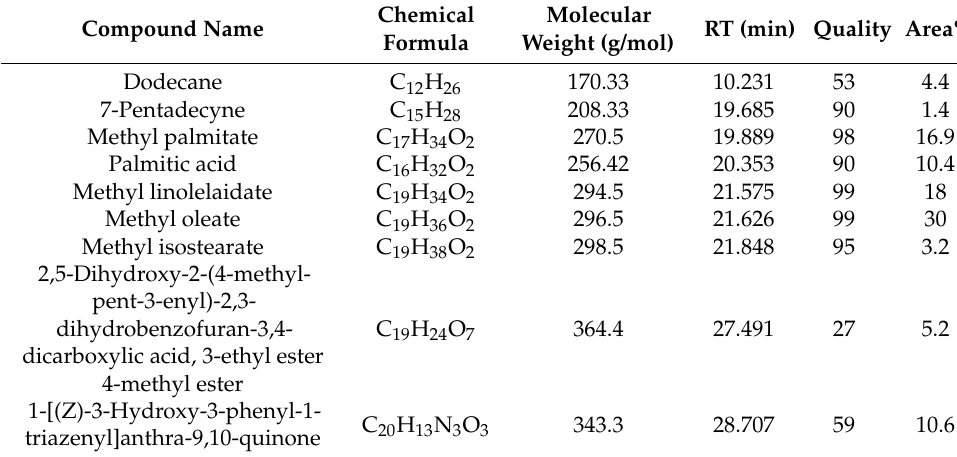
Table 3. The GC-MS analysis of the crude methanol extract obtained from wet mycelial biomass produced using ascospores of T . nivea .